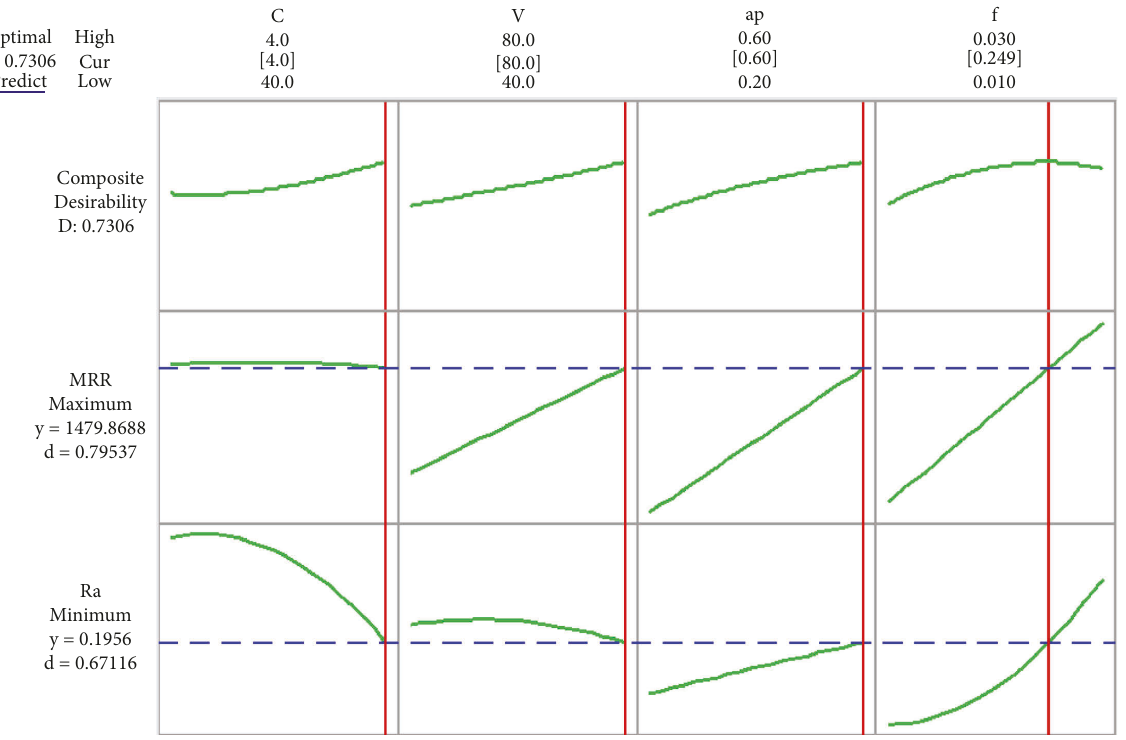
Figure 6: The plot of multiobjective